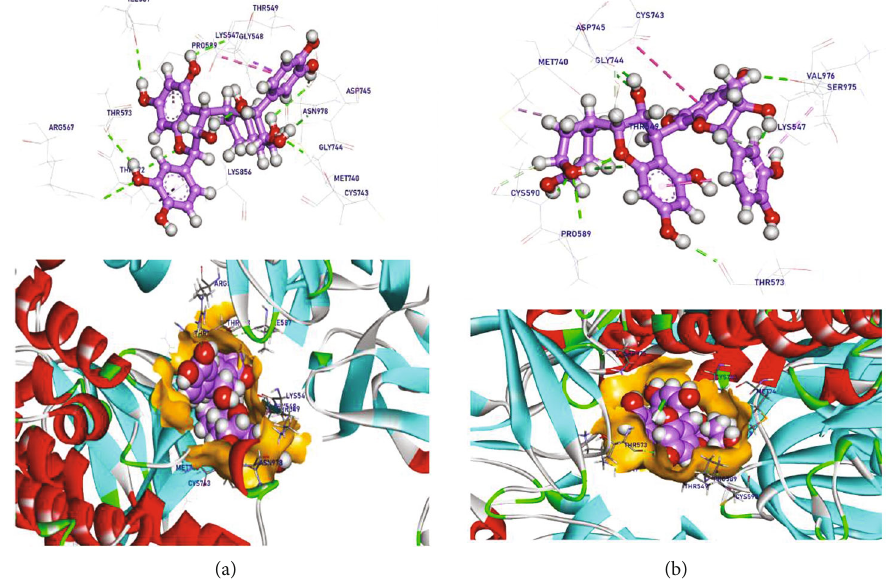
Figure 11: (a) Proanthocyanidin-B2 docked in RBD-SARS-CoV-2 Omicron spike protein and (b) proanthocyanidin-B4 docked in RBD- SARS-CoV-2 Omicron spike protein, hydrogen bonds (green), and the pi interactions are represented in purple lines with mapping surface showing the ligands occupying the active pocket of RBD-SARS-CoV-2 Omicron spike protein.